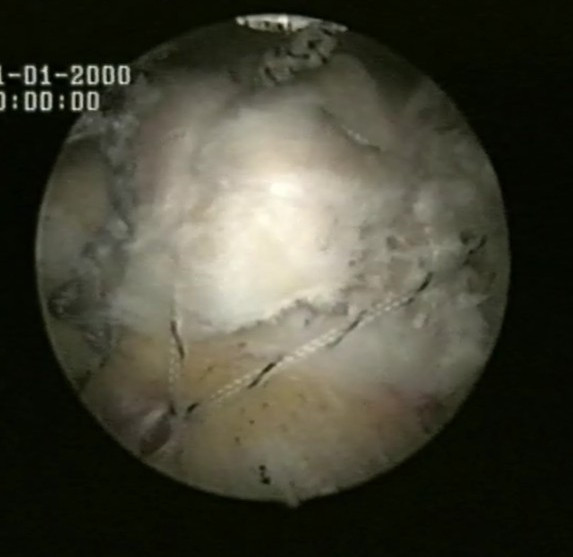
The final results.